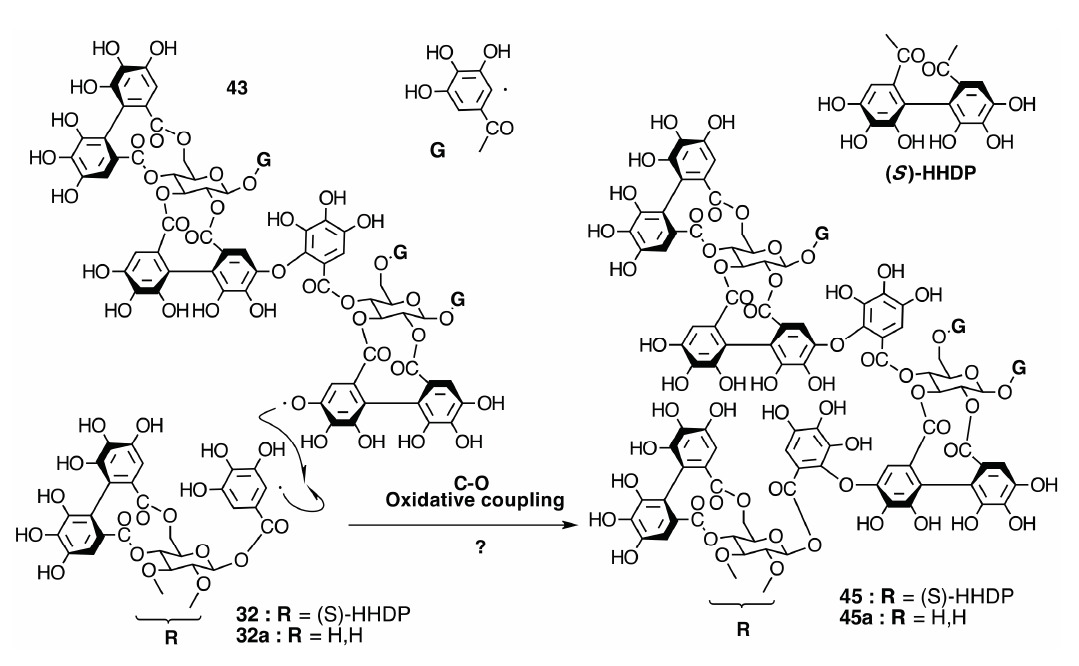
Figure 19. Route J in the biogenesis of trimeric ellagitannins in Melastomataceae. ? = Enzymes and reaction conditions are not yet